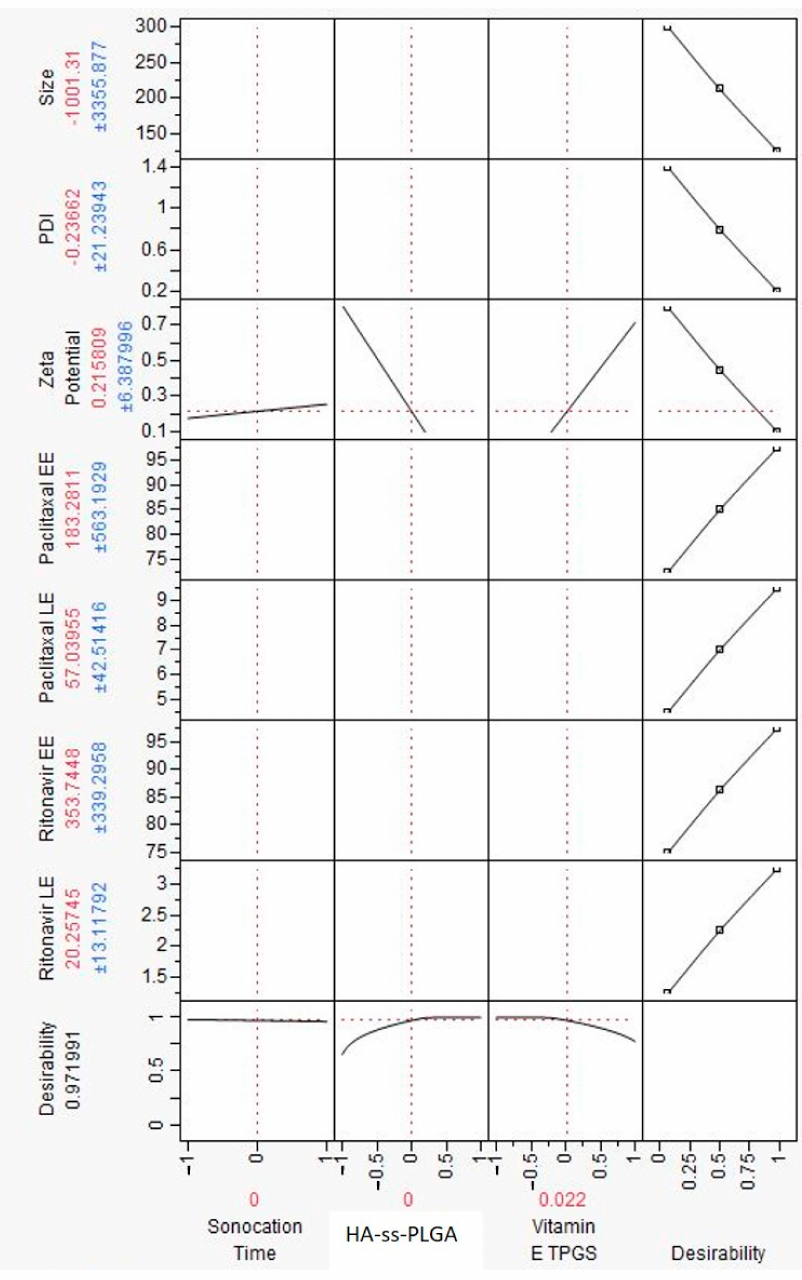
Figure 4. Prediction profiler for dependent variables of size, PDI, zeta potential, loading efficiency (LE), and entrapment efficiency (EE) depending upon the values of independent variables of polymer concentrations, HA − ss − PLGA, Vitamin E TPGS, and sonication